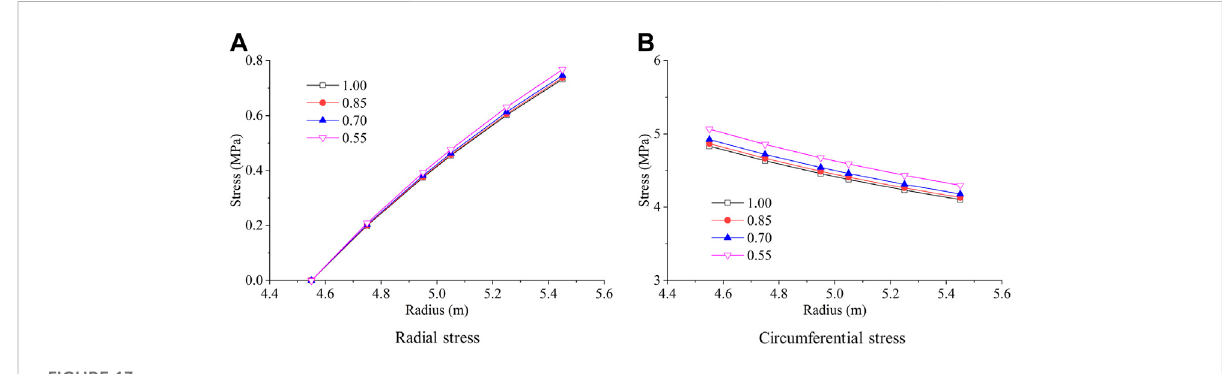
FIGURE 13 In fl uence of degree of anisotropy k a under state TU.